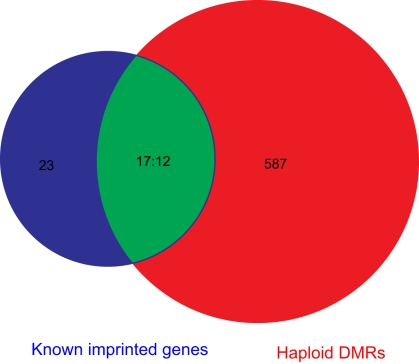
Venn diagram showing the relationship between haploid differentially methylated regions (hDMRs, red), known imprinted genes (blue), and their intersections (green).In the intersection, 17 known imprinted genes overlapped with 12 hDMRs in their genomic space.